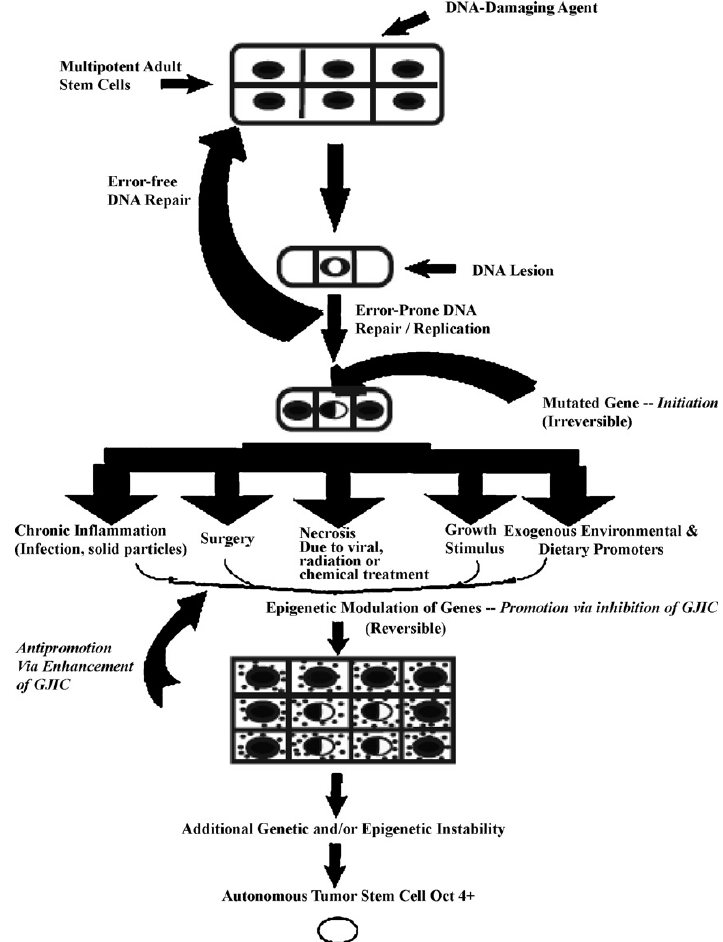
Figure 5. A diagrammatic heuristic scheme to depict the postulated mechanisms of the initiation and promotion phase of carcinogenesis. DNA lesions, induced by physical mutagens or by errors in DNA replication, are substrates in adult stem cells (Oct-4+) that can be fixed if they are not removed in an error-free manner prior to DNA replication. Promotion includes those conditions ( i.e. , chronic inflammation induced by infectious agents, solid particles; surgery or wounding; necrotic cell death; normal growth stimuli caused by growth factors, hormones; and exogenous epigenetic natural and synthetic molecules), in which a pluripotent, but surviving, initiated adult stem cell (Oct-4+), can escape the non-proliferative state. The build-up of initiated cells allows them to “resist” the anti-mitotic influence of neighboring non-initiated cells. In addition, the changing micro-environment within the growing benign tumor will cause some of the initiated adult stem cells to partially differentiate into cancer non-stem cells. This, together with either addition mutations or stable epigenetic changes, might allow a given initiated adult stem cell to have the autonomous, invasive properties of a malignant cell. Permission granted from Trosko, J.E. and Tai, M.H.